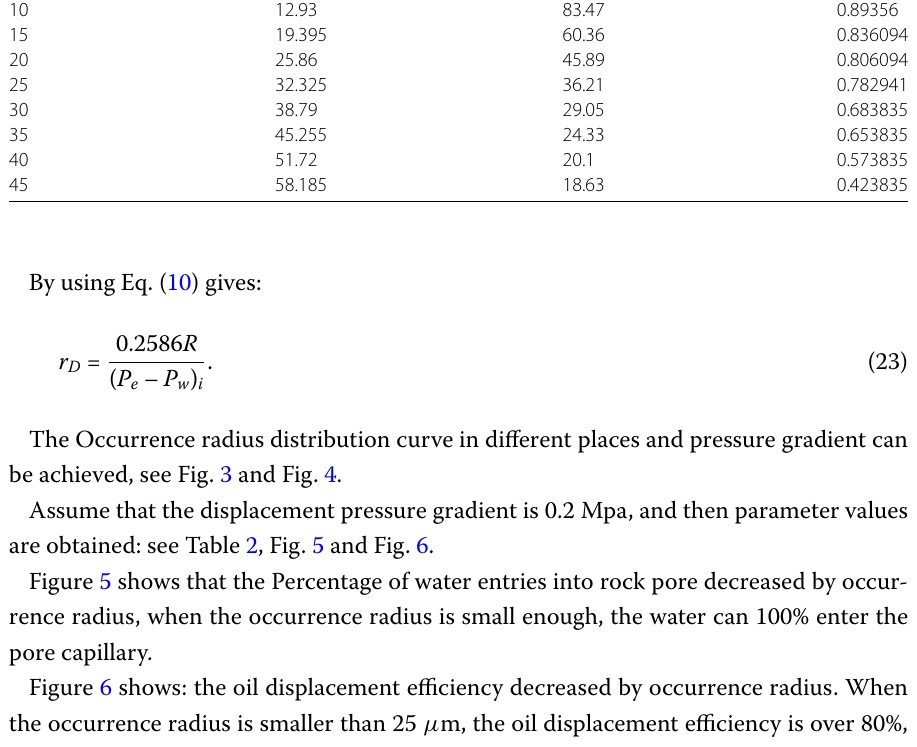
Table 2 Parameter values in a constant displacement pressure gradient R, m r D , μ m J k , % E D